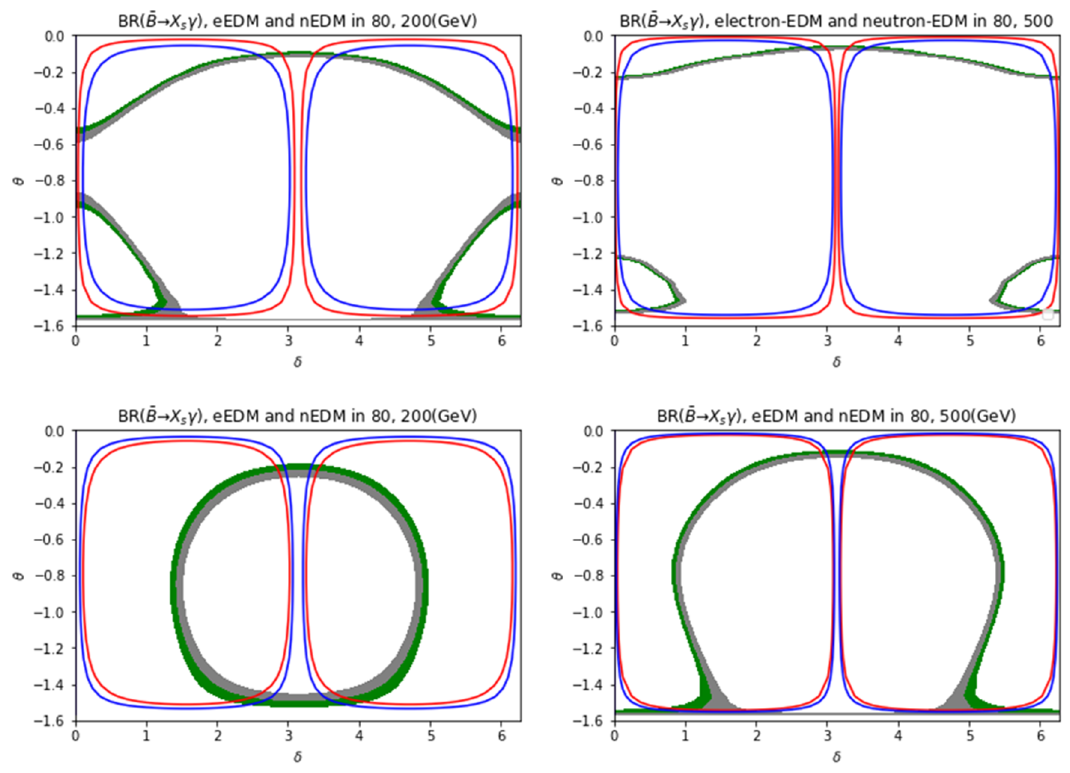
Figure 13 . The allowed regions from ¯ B → X s γ (within the green and grey shaded areas), eEDM (outside the blue curves), and nEDM (outside the red curves) in the [ δ, θ ] plane, with M and tan β = 20 . M = 200 GeV in the left panels and 500 GeV in the right panels. Here, tan γ = 1 H + 3 in the upper panels and 2 in the lower panels.